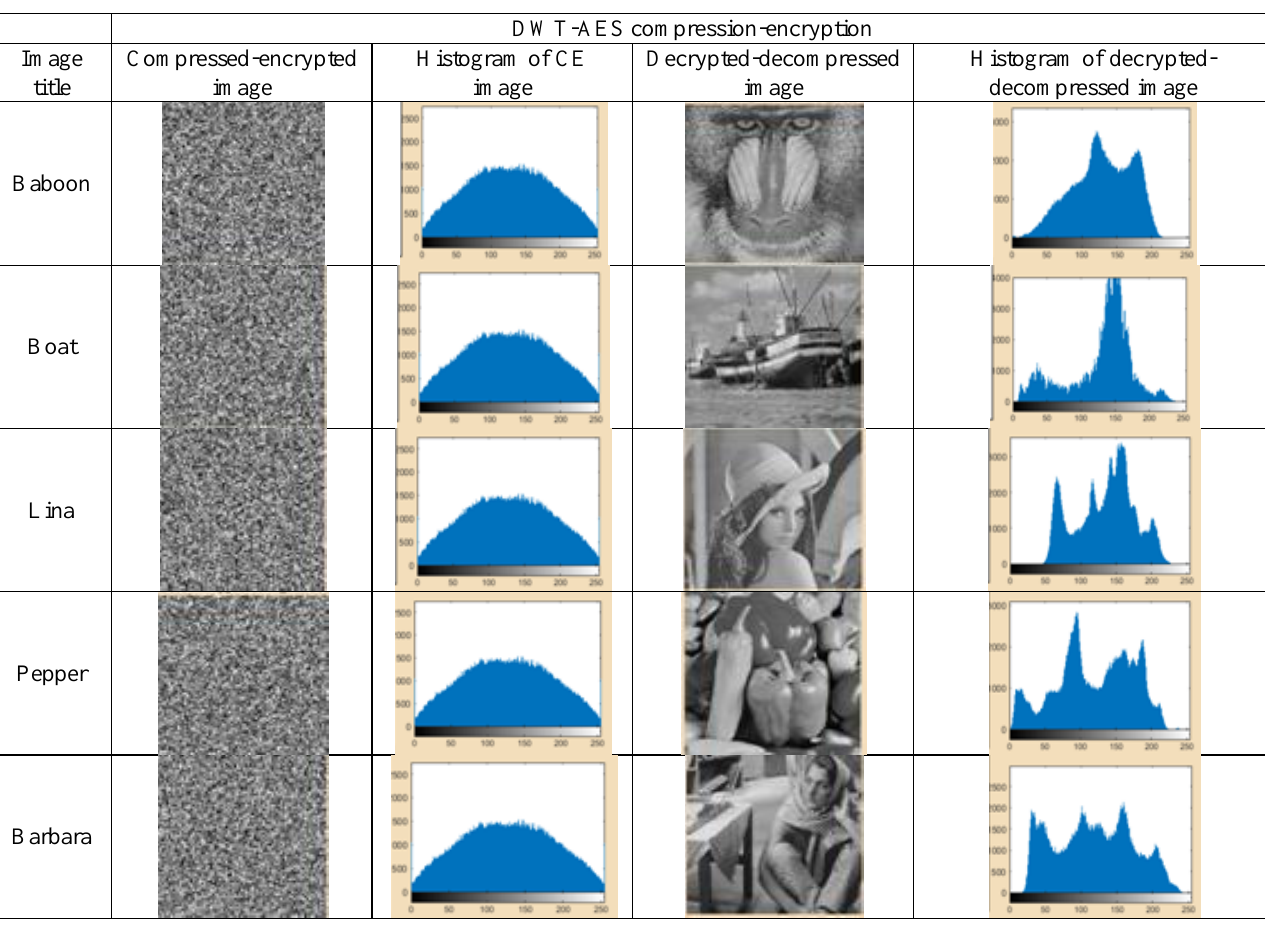
Figure 7. Column 2 and column 3 are DWT-AES compressed-encrypted image and its corresponding histograms respectively with respect to images as in column 1; Column 4 and Column 5 are decrypted-decompressed image and its corresponding histograms with respect to images as in column